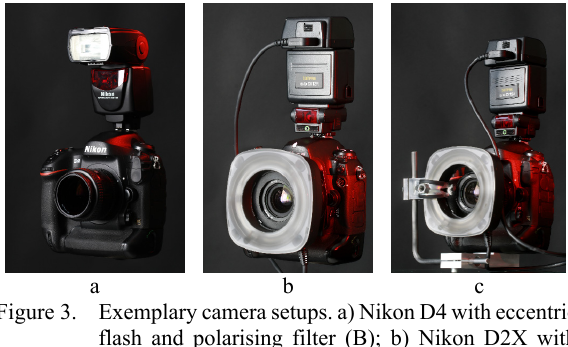
Figure 3. Exemplary camera setups. a) Nikon D4 with eccentric flash and polarising filter (B); b) Nikon D2X with ring flash mounted to the lens (C); c) Nikon D4 with ring flash mounted to the tripod socket (E).